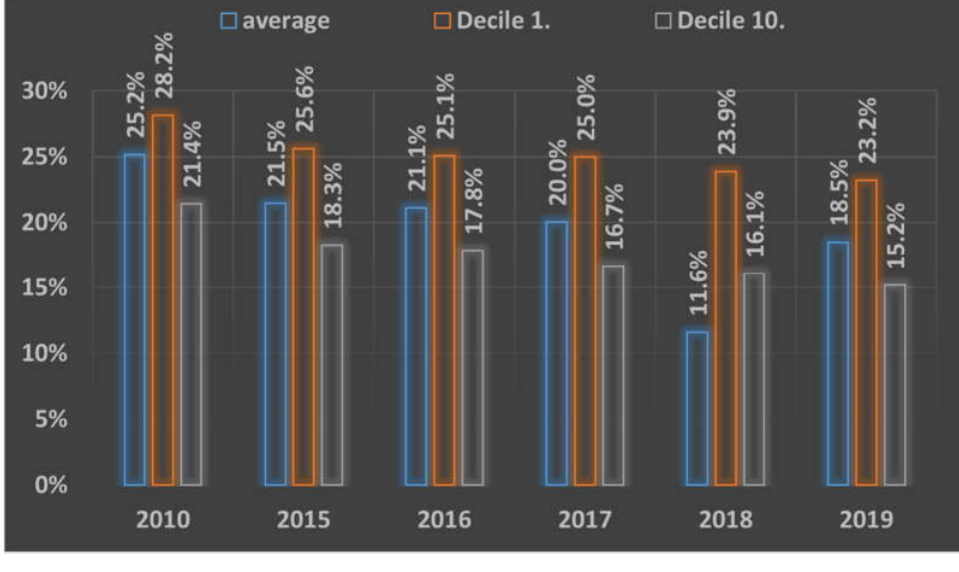
Figure A1. Share of annual household maintenance and household energy expenditure per capita in lower- and upper-income deciles in 2010 and 2015–2019 (%) Source: Compiled by authors based on CSO data [36].